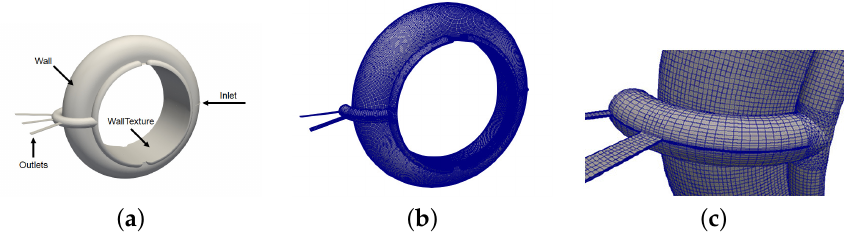
Figure 9. Mould cavity of a D-ring seal: ( a ) geometry; ( b ) mesh; and ( c ) mesh detail close to exit